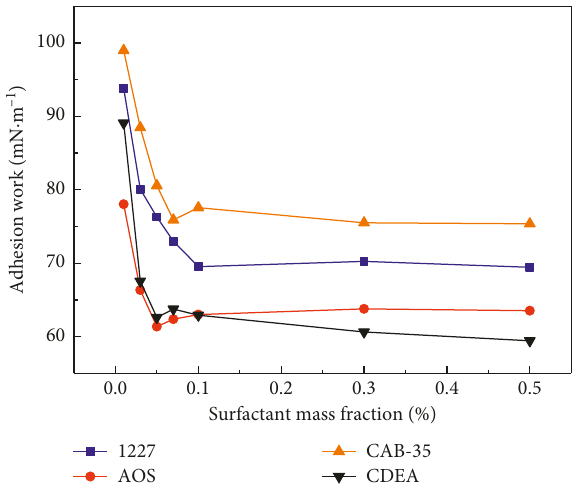
Figure 7: The spreading works of the surfactant solutions on the coal dust surface at the different